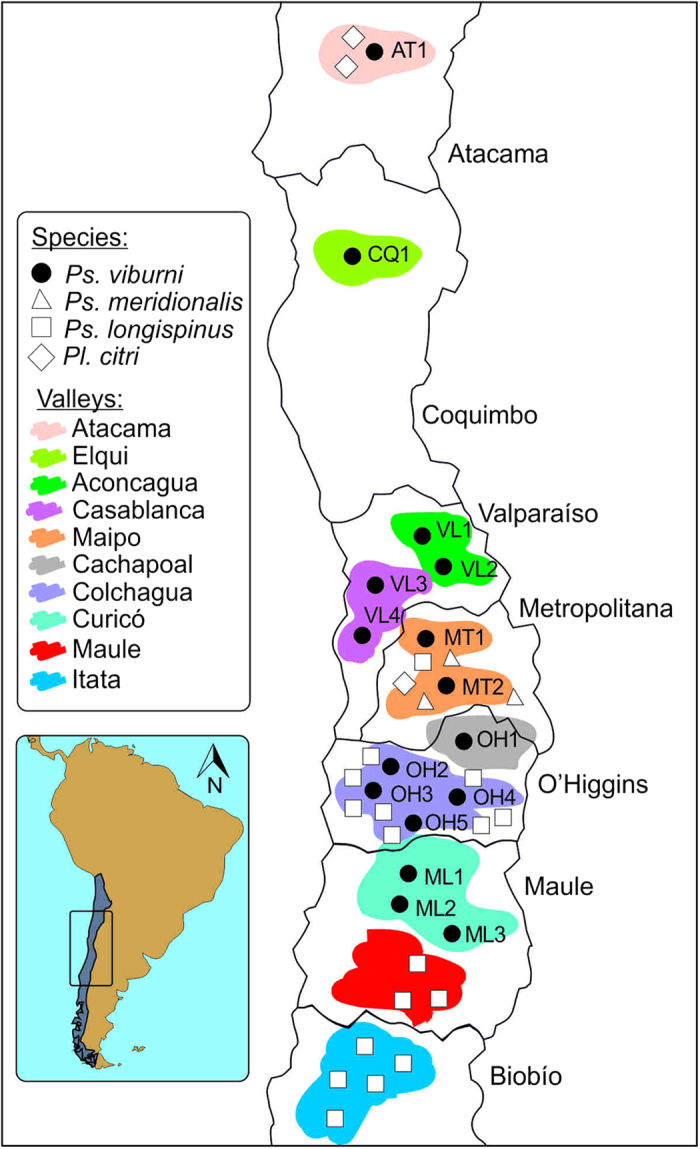
Spatial distribution of mealybug species found in Chilean valleys.Sampling localities are indicated using different shapes depending on the species found. Limits between administrative regions are drawn as black lines and valleys are highlighted using different colors. Figure created using the software CorelDRAW X6.